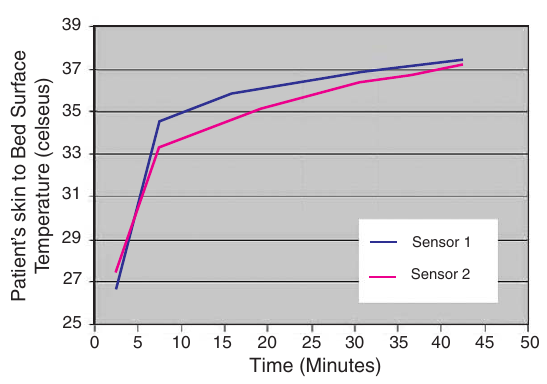
Fig. 1. Patient’s skin to bed surface temperature versus time over which patient lies on the same posture.